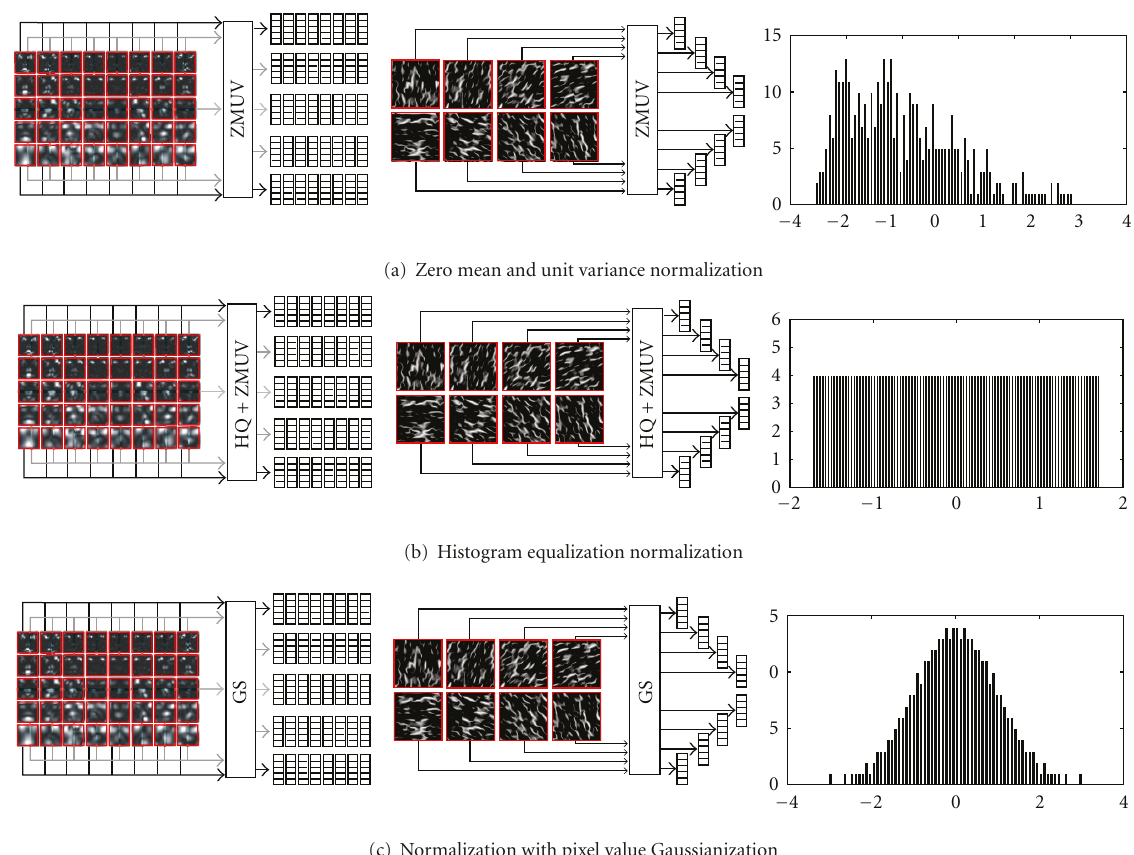
Figure 15: Visualization of the applied normalization